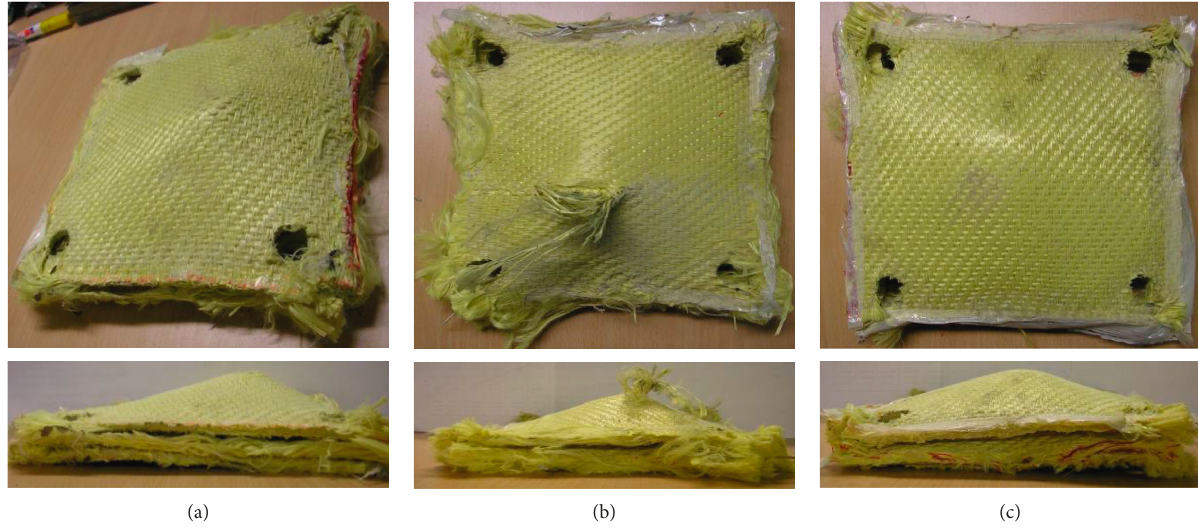
Figure 17: Representations of the different tested solutions of 3D warp interlock fabric submitted to high-speed FSP impact.